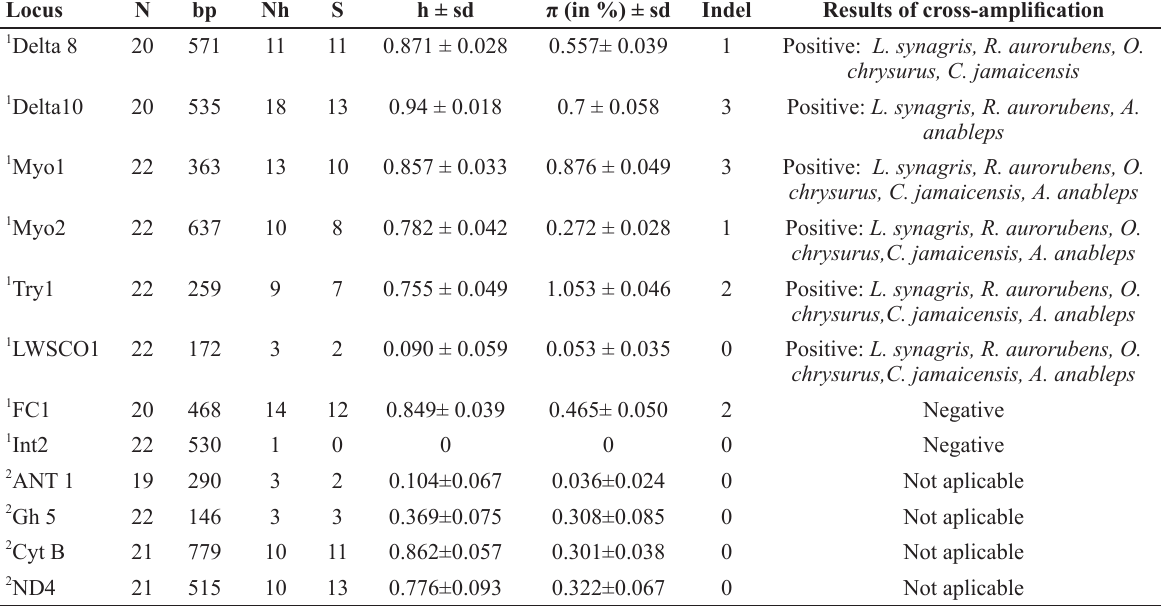
Statistics for the markers analyzed in the present study (for L. purpureus ), and the results of cross-amplifications.